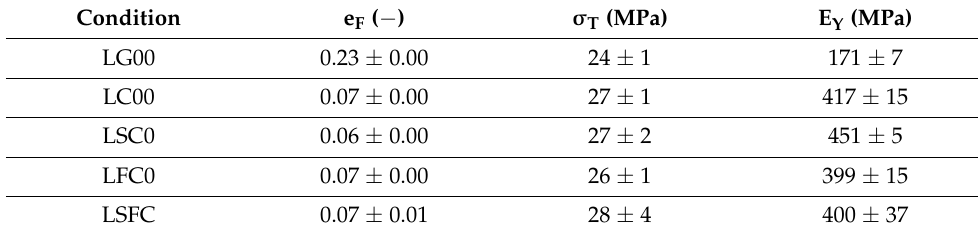
Table 4. Tensile properties for all studied